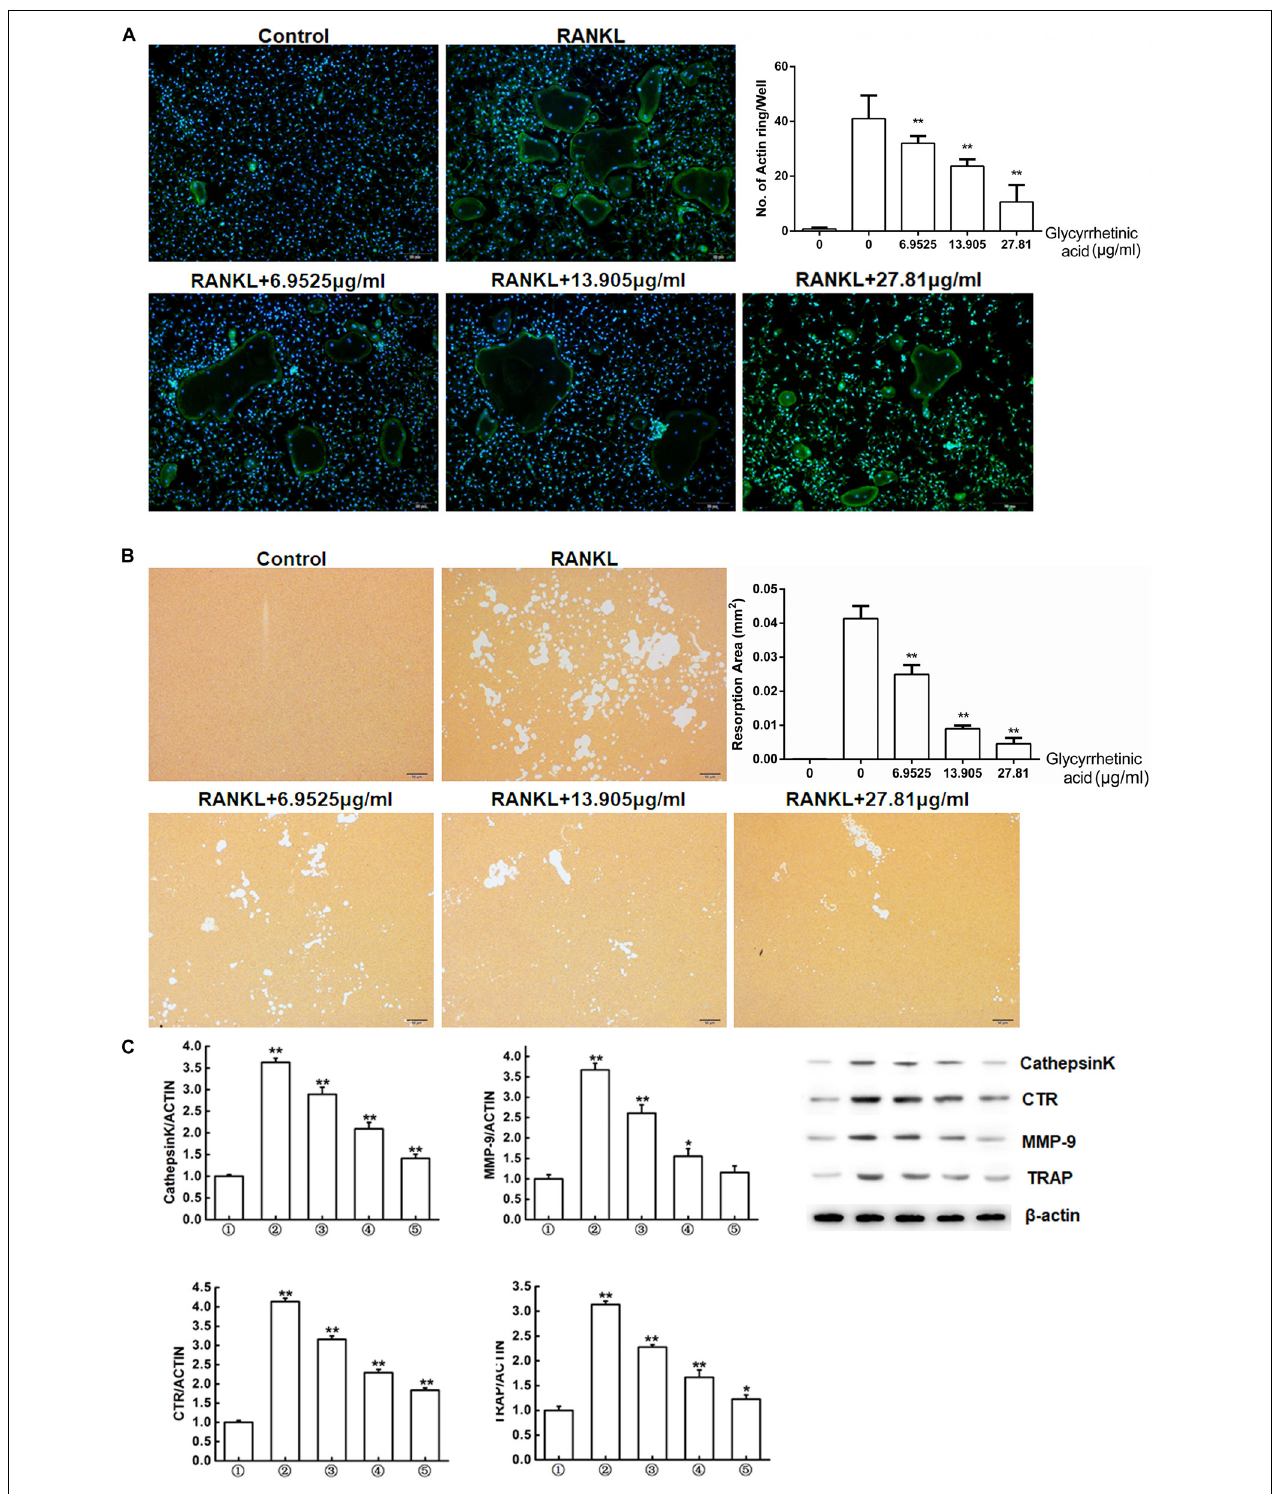
FIGURE 2 | 18 β -GA inhibits osteoclasts function in vitro . (A) Actin ring structures of osteoclasts and quantification of the actin ring. (B) Pits formation assay of osteoclasts and quantification of pits area. (cid:192) RAW264.7 cells; (cid:193) RAW264.7 cells induced with M-CSF, RANKL, and PBS; (cid:194) RAW264.7 cells induced with M-CSF, RANKL and treated with 6.9525 µ g/ml 18 β -GA; (cid:195) RAW264.7 cells induced with M-CSF, RANKL and treated with 13.905 µ g/ml 18 β -GA; (cid:196) RAW264.7 cells induced with M-CSF, RANKL and treated with 27.81 µ g/ml 18 β -GA. (C) Western blot and optical density analysis of the expression of Cathepsin K, CTR, MMP-9, and TRAP with β -actin as reference ( ∗ P < 0.05, ∗∗ P < 0.01 versus (cid:197) ).